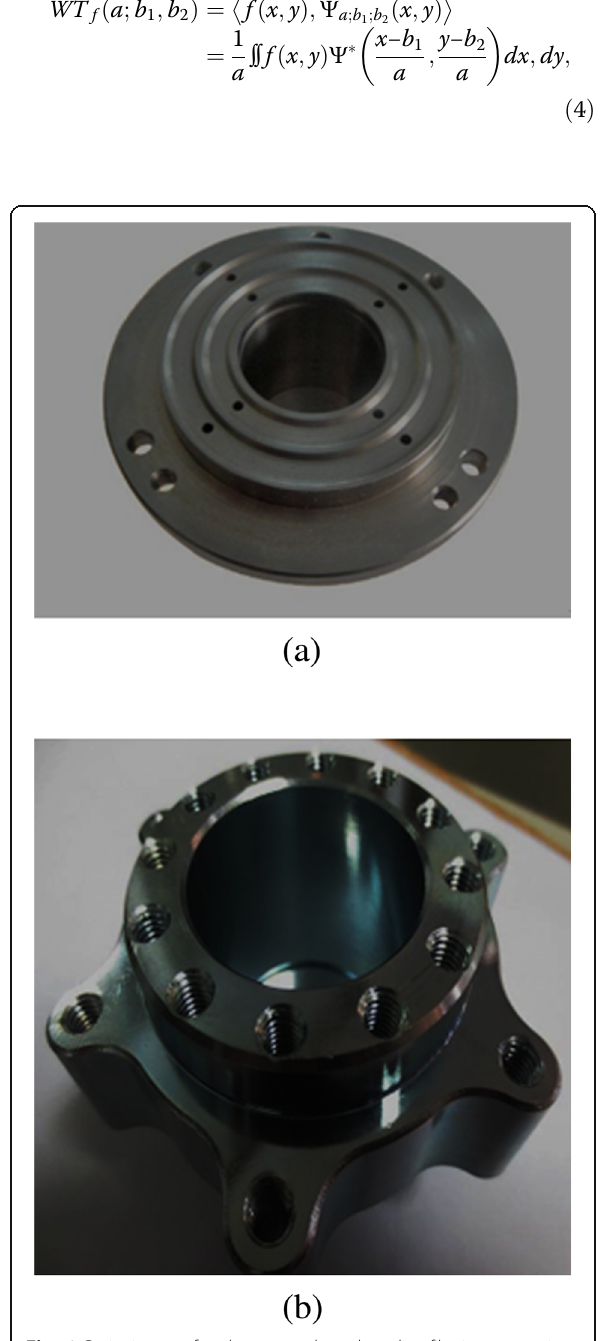
Fig. 7 Moore nearest neighbor model and cavity image after binarization Fig. 6 Cavity image after the gray scale and median filtering